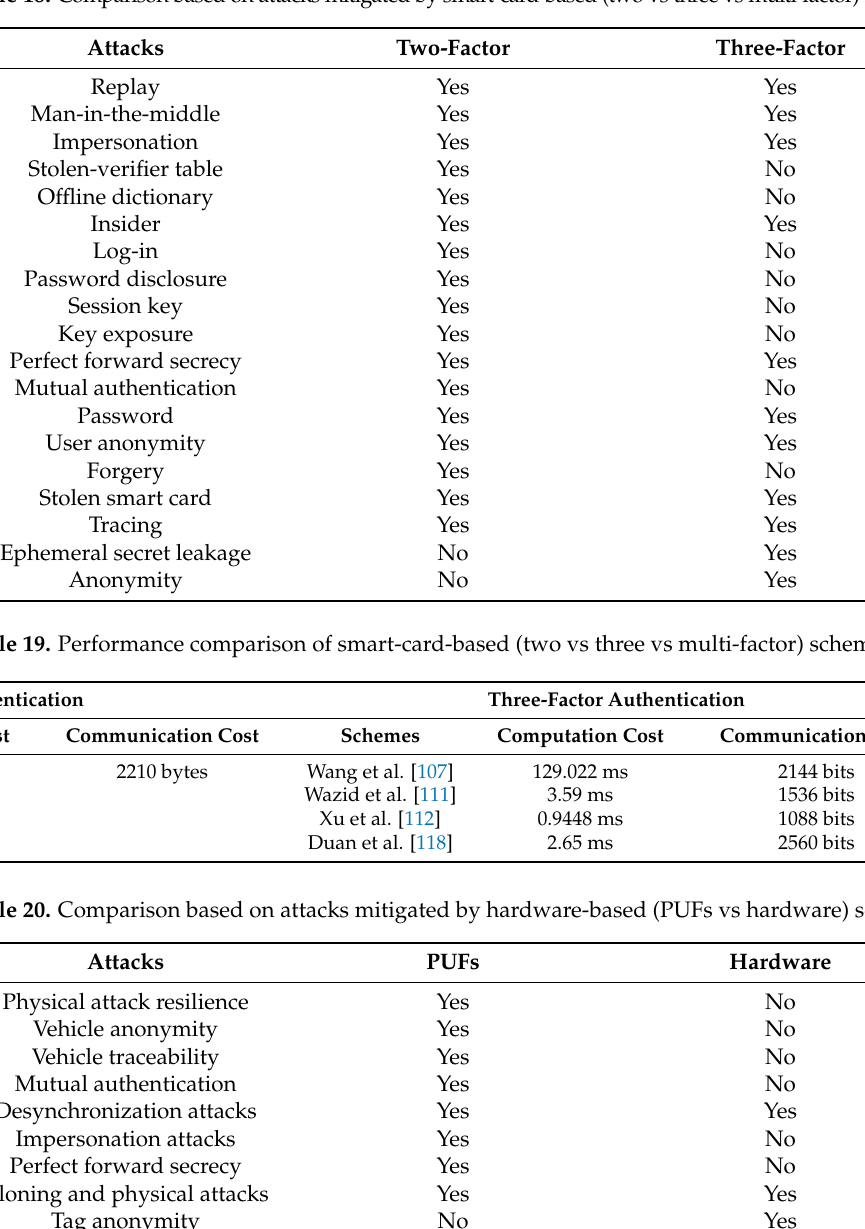
Table 18. Comparison based on attacks mitigated by smart-card-based (two vs three vs multi-factor) schemes.